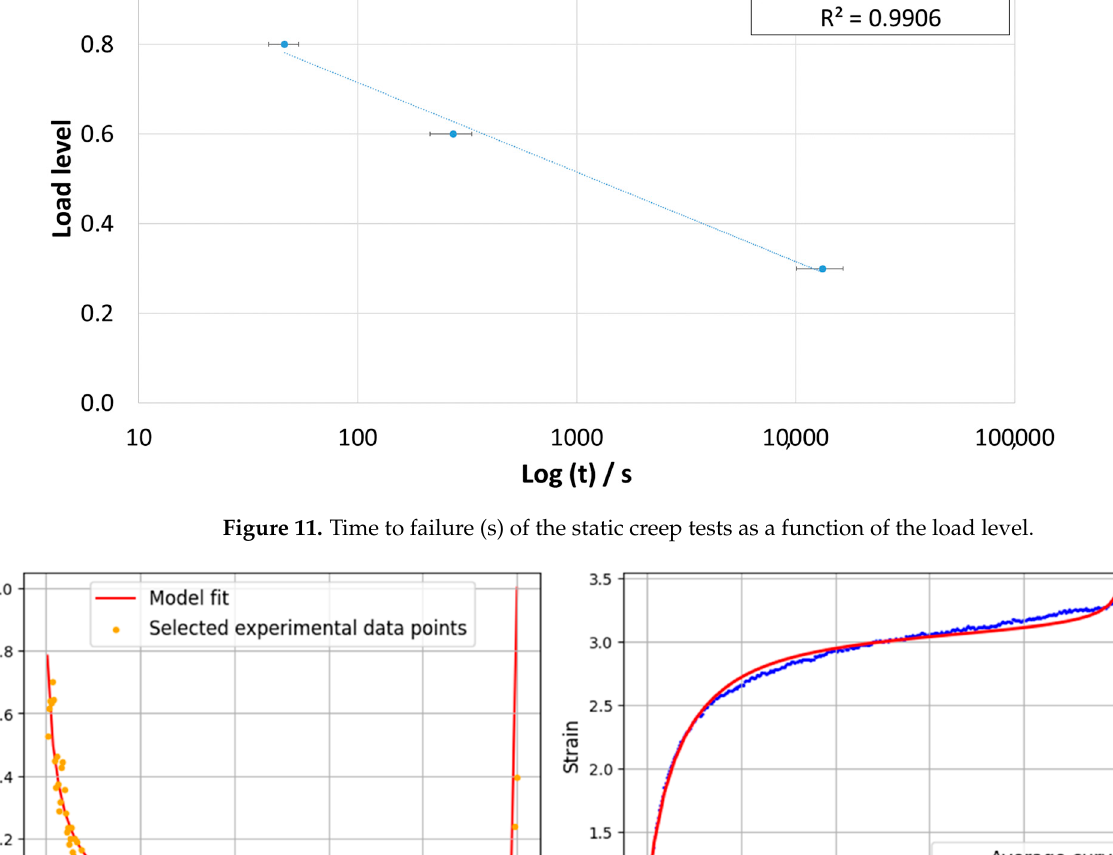
Figure 10. Experimental static creep representative curves for 30%, 60%, and 80% load level: three levels ( top ) and higher levels in detail ( bottom ).